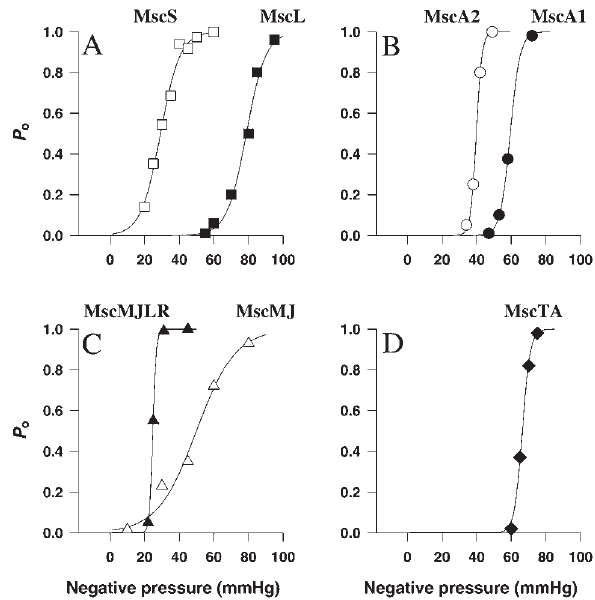
Figure 4. Boltzmann distribution curves for MS channels in prokary- otes. (A) MscS and MscL of Escherichia coli ; based on Martinac (un- published data) and Kloda and Martinac (2001 d ). (B) MscA1 and MscA2 of Haloferax volcanii ; adapted from LeDain et al. (1998). (C) MscMJ and MscMJLR of Methanococcus jannaschii ; adapted from Kloda and Martinac (2001 a , 2001 b ). (D) MscTA of Thermoplasma acidophilum ; based on Kloda and Martinac (2001 c ). The Boltzmann function for MS channels relates applied negative pressure and open probability ( P o ) fitted by nonlinear regression and has the form: P o /(1 – P o ) = exp( a ( p – p 1/2 )), where p 1/2 is the pressure required for a channel open probability of 50% and a is the slope of the plot of ln( P o /(1 – P o )) versus negative pressure and describes the pressure sensitivity of the channels in the particular patch. Values for Boltz- mann parameters are given in Table 1. Note: 1 mmHg = 133